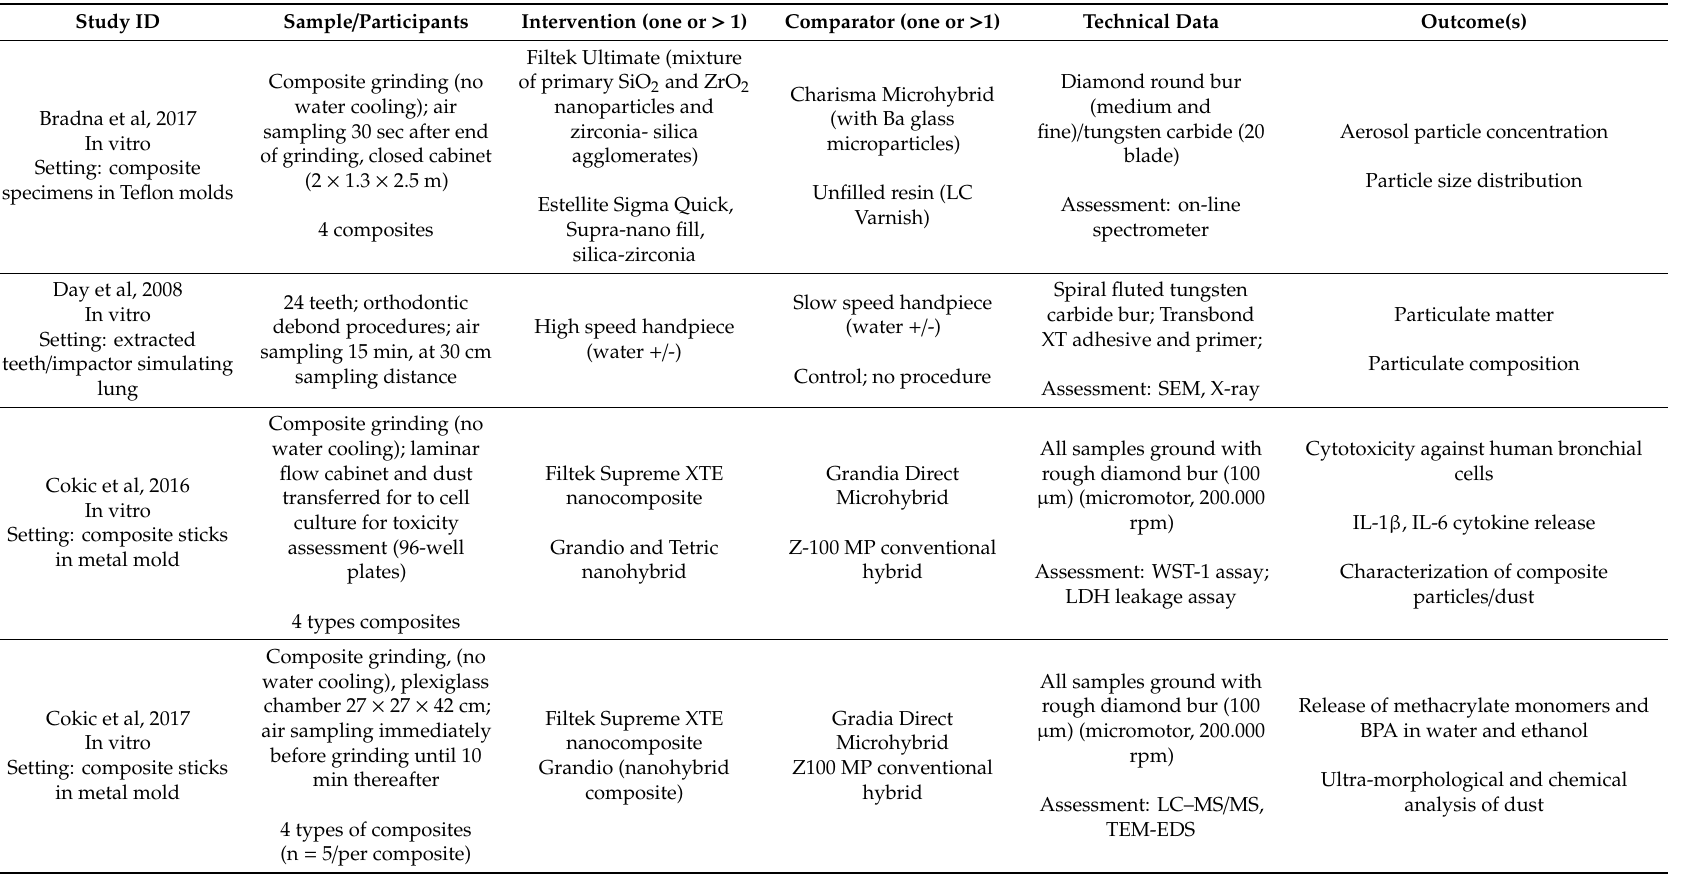
Table 1. Characteristics of included articles ( n = 13, in alphabetical